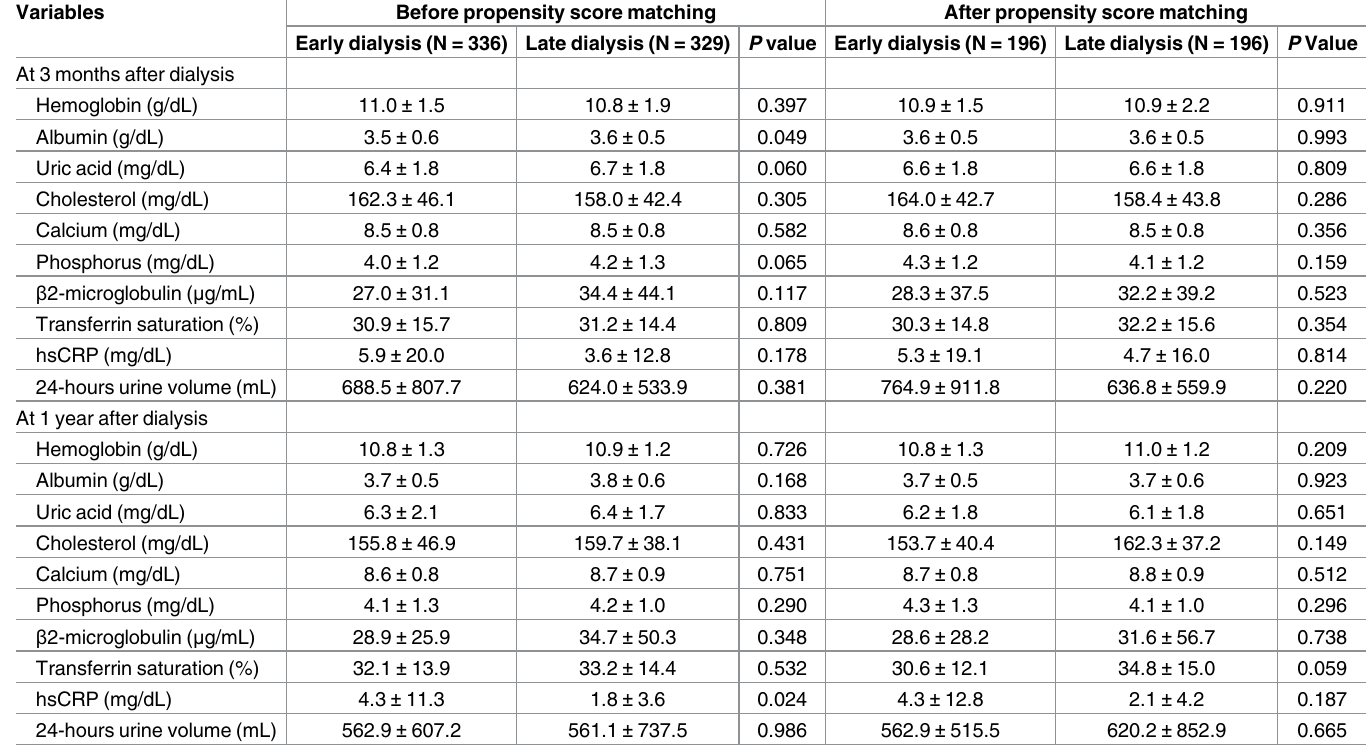
Table 4. Changes in the laboratory findings and 24-hour urine output before and after propensity score matching at 3 months versus 1 year after dialysis initiation in the 2 groups based on the timing of dialysis initiation stratified by the median eGFR before dialysis. Variables Before propensity score matching After propensity score matching